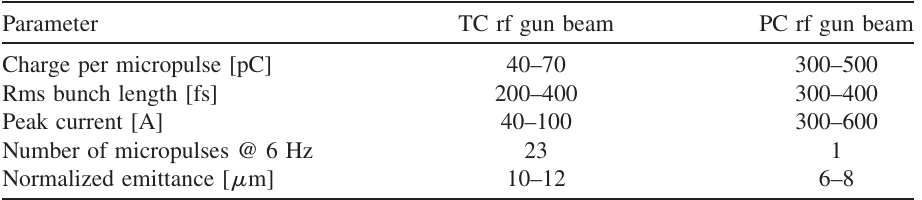
FIG. 1. A schematic of the APS linac test area showing the PC rf gun, the two TC rf guns, the accelerator structures (L1-L5), the chicane dipoles (B1-B4), and the diagnostics suite. This latter includes rf beam position monitors (BPMs), beam profile screens (flags), FIR CTR diagnostic, and the vertical bend diagnostic line. There is also an electron spectrometer located at the end of the linac just before Sta-5. TABLE I. A summary of the electron beam properties for the APS TC rf gun 2 and the PC rf